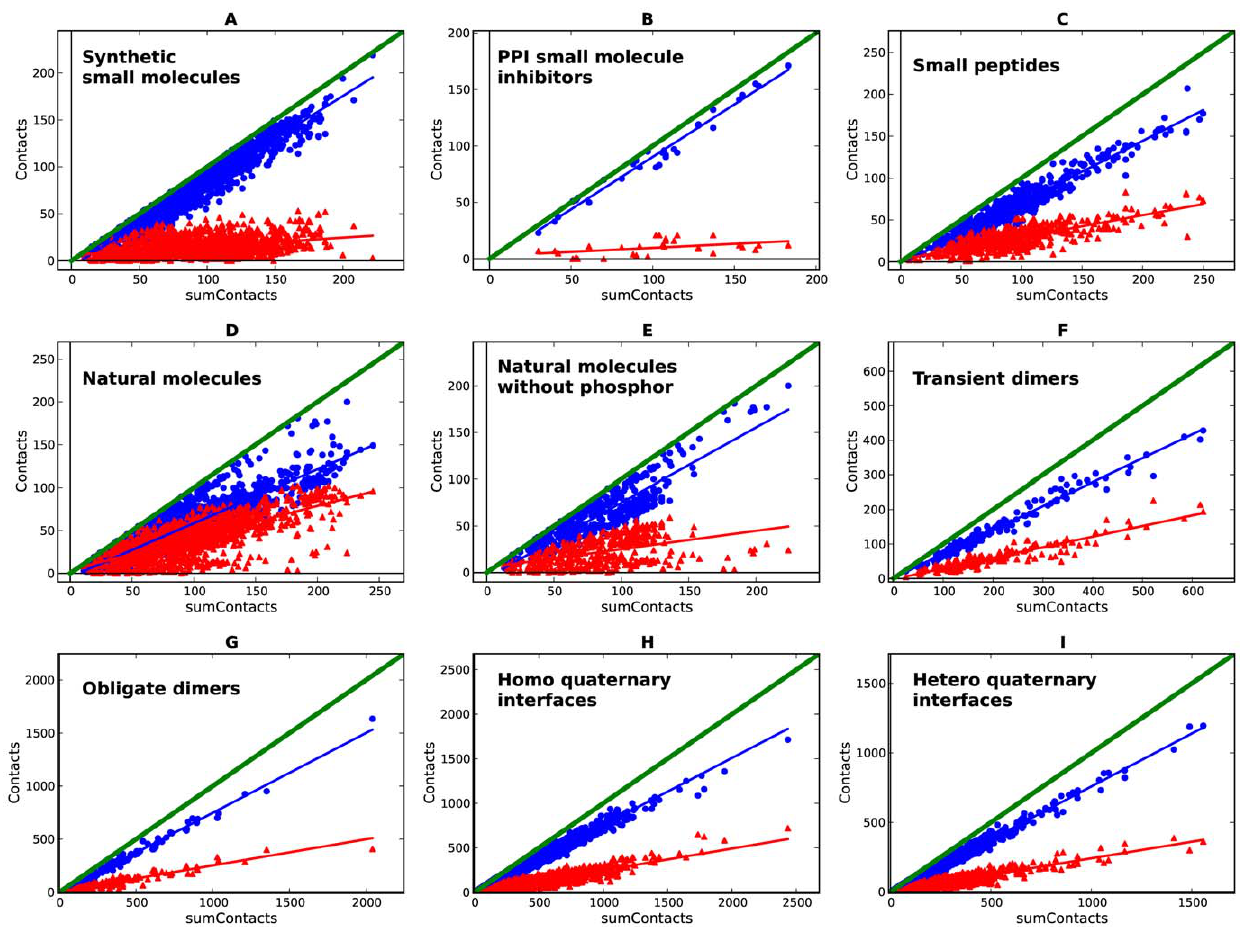
Figure 1. Scissors plots for the non-redundant-by-complex (Table S2) sets of protein complexes. a: synthetic small molecules bound to proteins; b: protein-protein interactions small molecule inhibitors bound to proteins; c: small peptides bound to proteins; d: natural small molecules bound to proteins; e: natural small molecules not containing phosphorus bound to proteins; f: transient protein-protein dimers; g: obligate protein- protein dimers; h: homo protein-protein interfaces from quaternary structures; i: hetero protein-protein interfaces from quaternary structures; polar (red) and apolar (blue) contacts are scattered against sum of contacts.